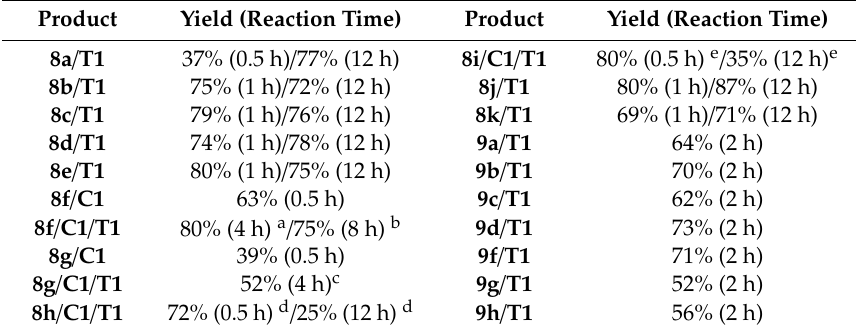
a For a ca. 1:3 mixture of cis ( C1 ) and trans ( T1 ) diastereomers. b For a ca. 1:4 mixture of cis ( C1 ) and trans ( T1 ) diastereomers. c For a ca. 3:7 mixture of cis ( C1 ) and trans ( T1 ) diastereomers. d For a ca. 4:3 mixture of cis ( C1 ) and